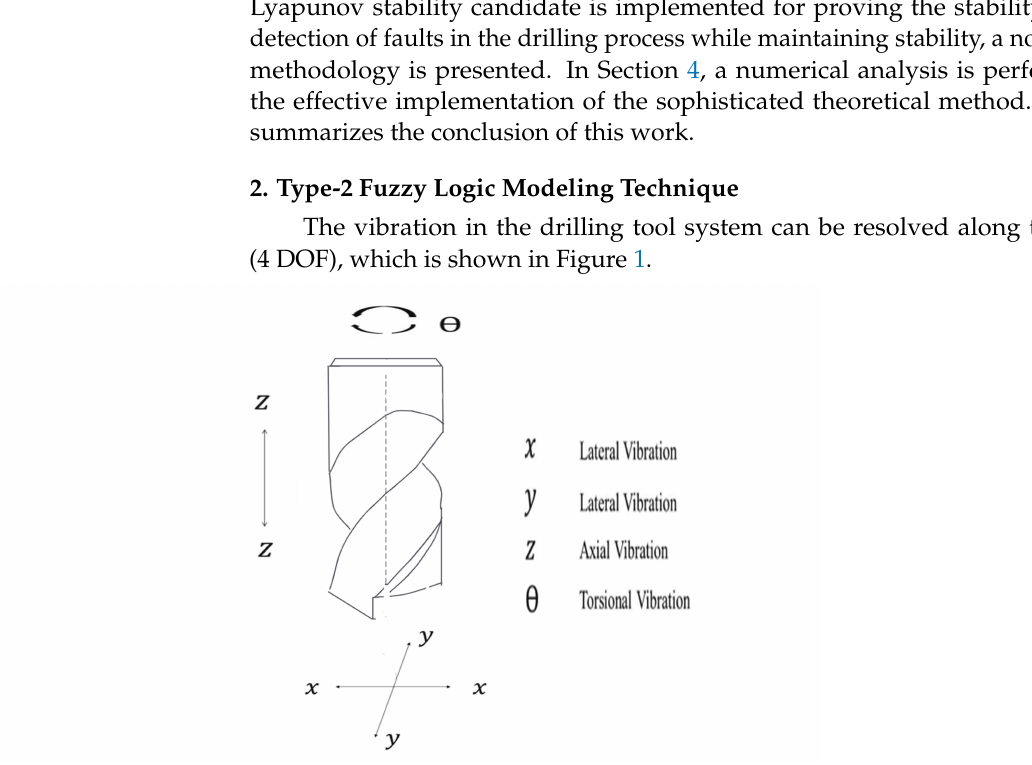
Figure 1. Three modes of vibration (4 DOF) in drilling